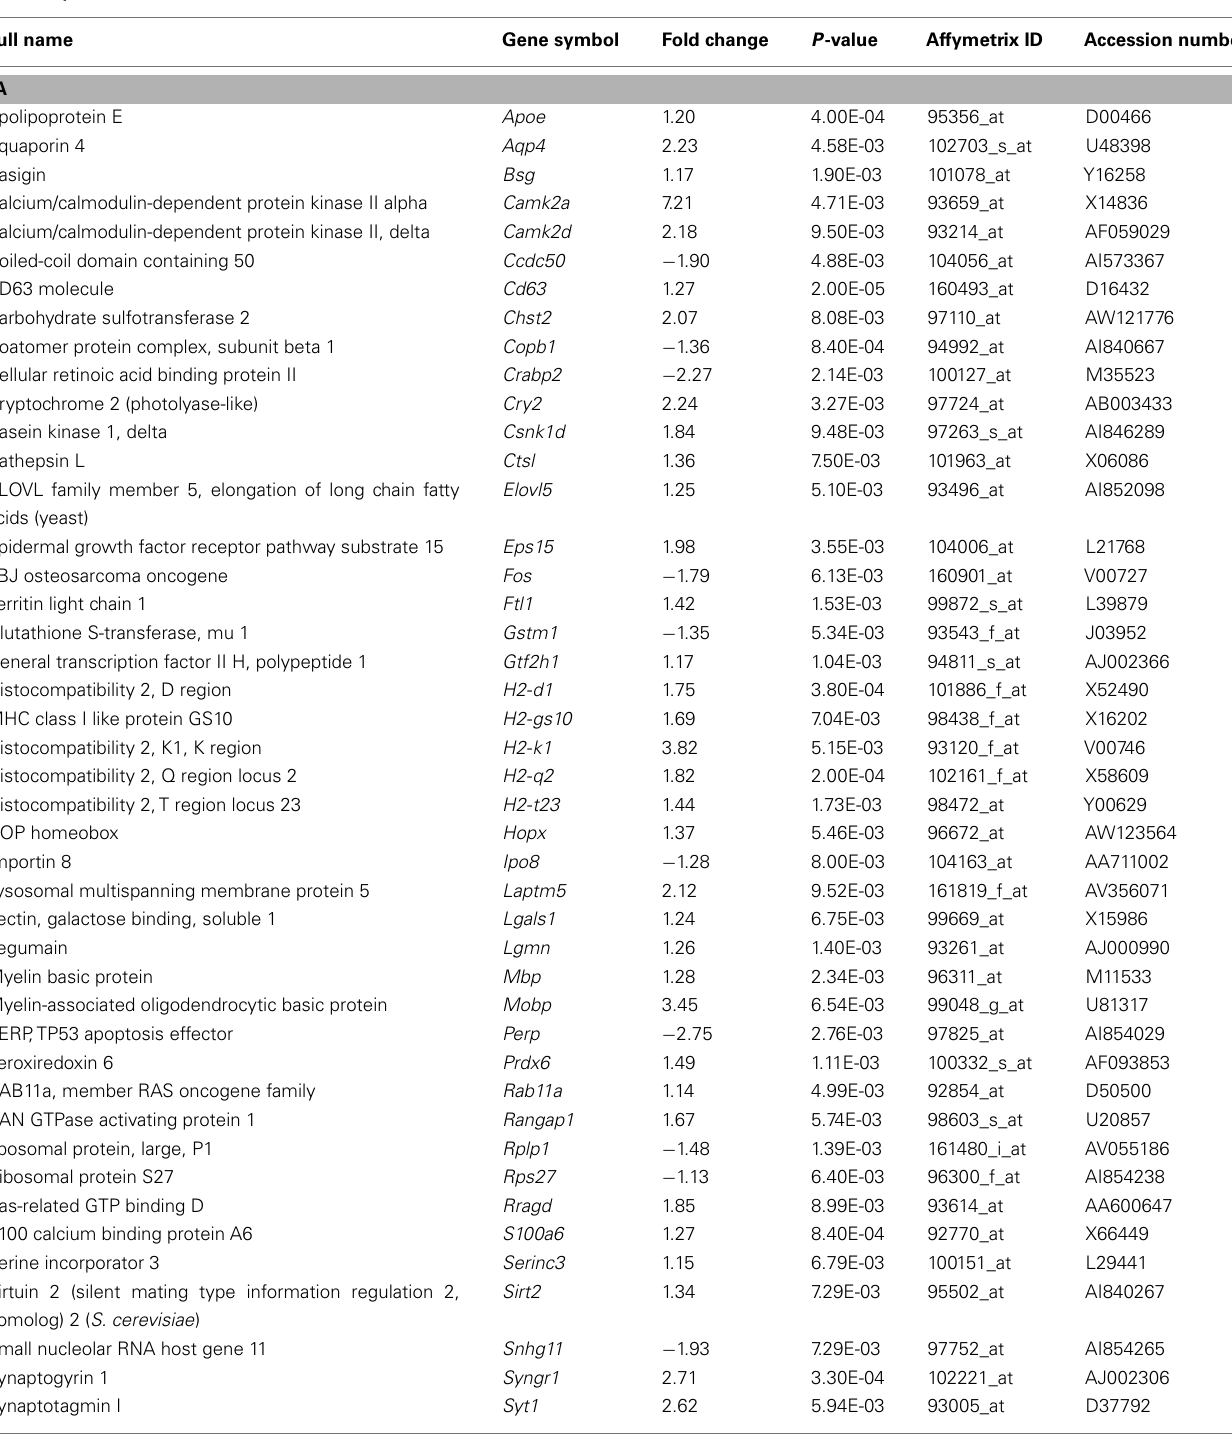
TableA1 | Genes differentially expressed in regions of induced young adult